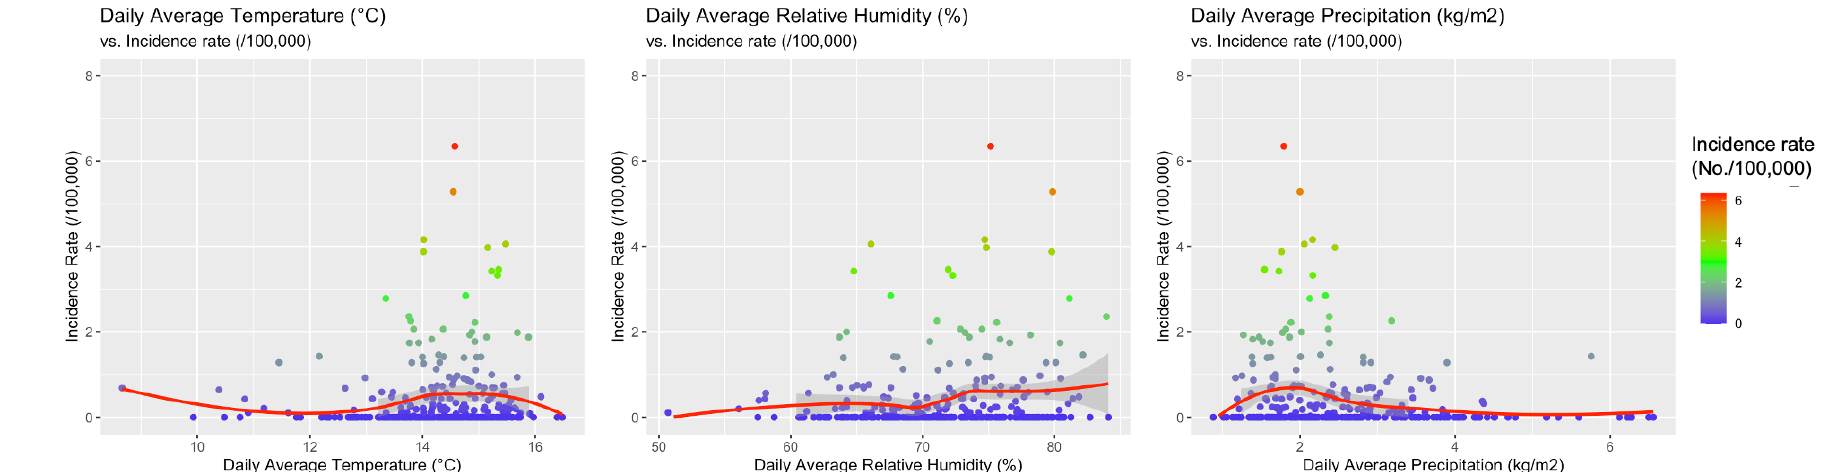
Figure 6. Correlation between the incidence of cases of West Nile neuro-invasive disease (WNND) in the index areas and: daily average temperatures (r = 0.0982, 95% CI −0 .01754 – 0.2114, p = 0.0916), daily average precipitation (r = −0 .1666, 95% CI − 0.2768 to −0 .0520, p = 0.0045), and daily average relative humidity (r = 0.1376, 95% CI 0.0224 – 0.2393, p = 0.0194).